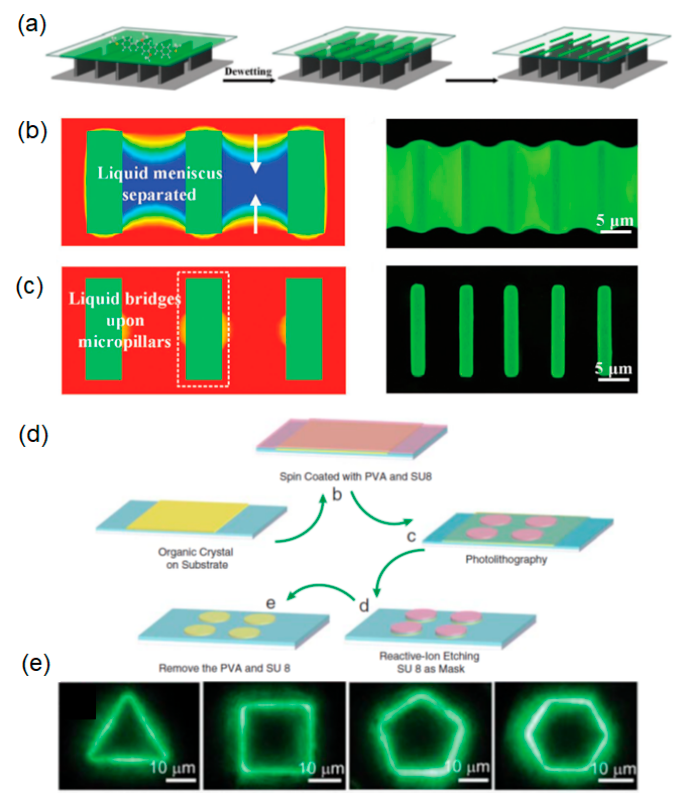
Figure 12. ( a ) Description of the capillary bridged lithography method. A template composed of ribs is placed in contact with a liquid film deposited on a substrate. ( b ) Simulation (left) and fluorescence image (right) of the liquid undergoing de-wetting. ( c ) Asymmetric wettability between the substrate and the ribs drives the liquid underneath the ribs (left). Subsequent solidification leads to crystalline geometrical patterns which reproduce the template (right). Reproduced with permission from ref. [123]. Copyright 2017 Wiley-VCH. ( d ) Mask-assisted photolithography following five steps: (i) physical vapor deposition of the organic film, (ii) subsequent coating with PVA and SU8, (iii) space-selective light irradiation, (iv) reactive ion etching of SU8 nonprotected areas and v) PVA lift-off. ( e ) Fluorescence image of different geometries which can be deployed with this method. Reproduced with permission from ref. [121]. Copyright 2012